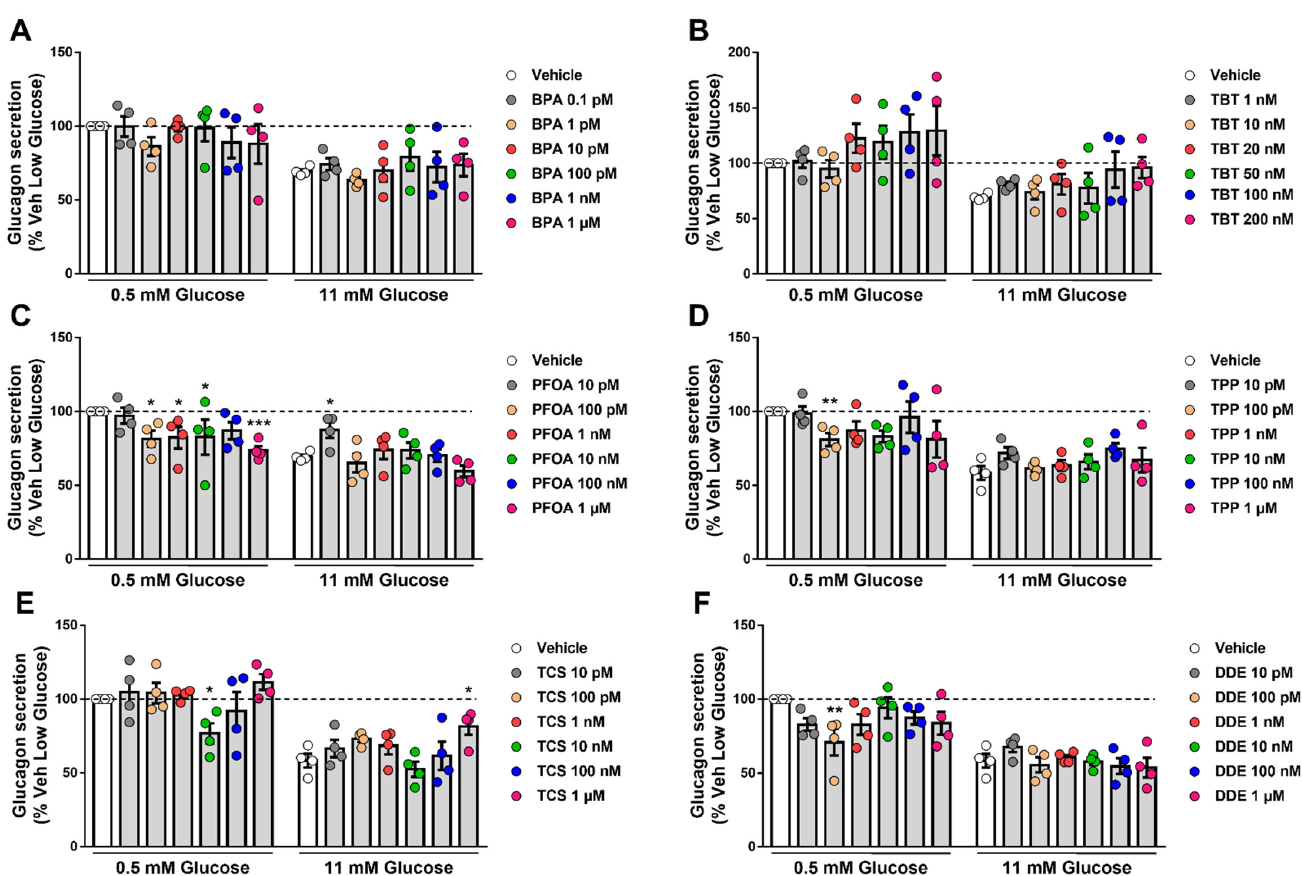
Figure 5. Glucagon secretion upon MDC exposure. α TC1-9 cells were treated with vehicle (DMSO) or different doses of BPA ( A ), TBT ( B ), PFOA ( C ), TPP ( D ), TCS ( E ), or DDE ( F ) for 48 h. Glucagon secretion was measured at 0.5 and 11 mM glucose, and glucagon released into the medium was measured by ELISA. Data are normalized to glucagon secretion at low glucose (i.e., 0.5 mM) in vehicle-treated cells. Data are shown as means ± SEM (n = 4 independent experiments, where each dot represents an independent experiment). * p ≤ 0.05, ** p ≤ 0.01 and *** p ≤ 0.001 vs. its respective vehicle. Two-way ANOVA.